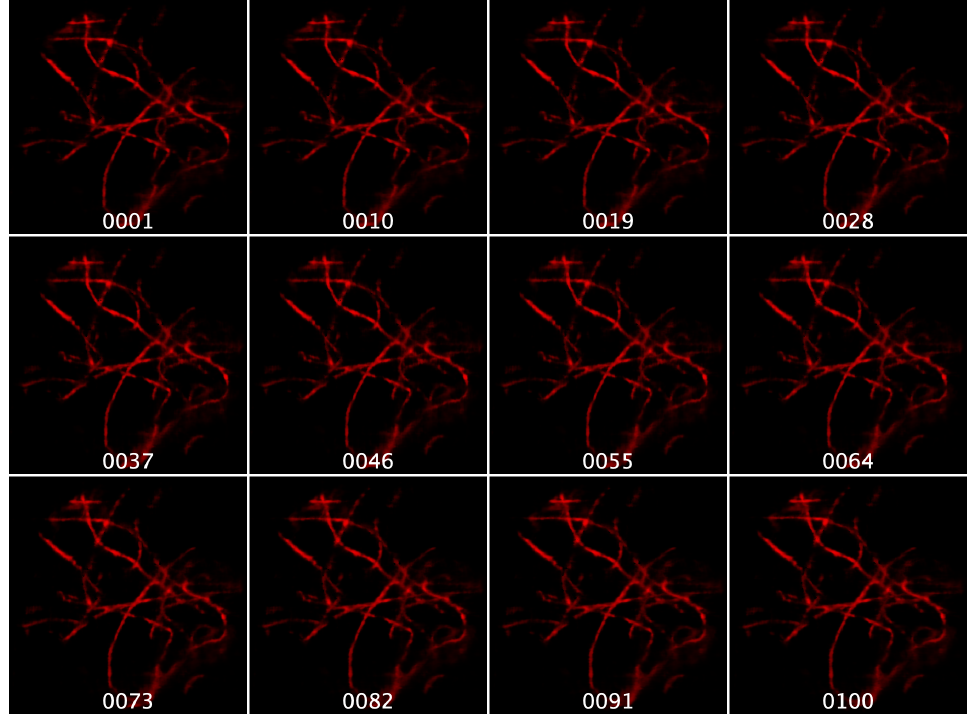
Figure 7. Group of 12 synthesized images extracted from the series of 200 images provided by NeRF-- for the case of the fibers sample. The labels refer to the position of each image in the order created during the generation of these